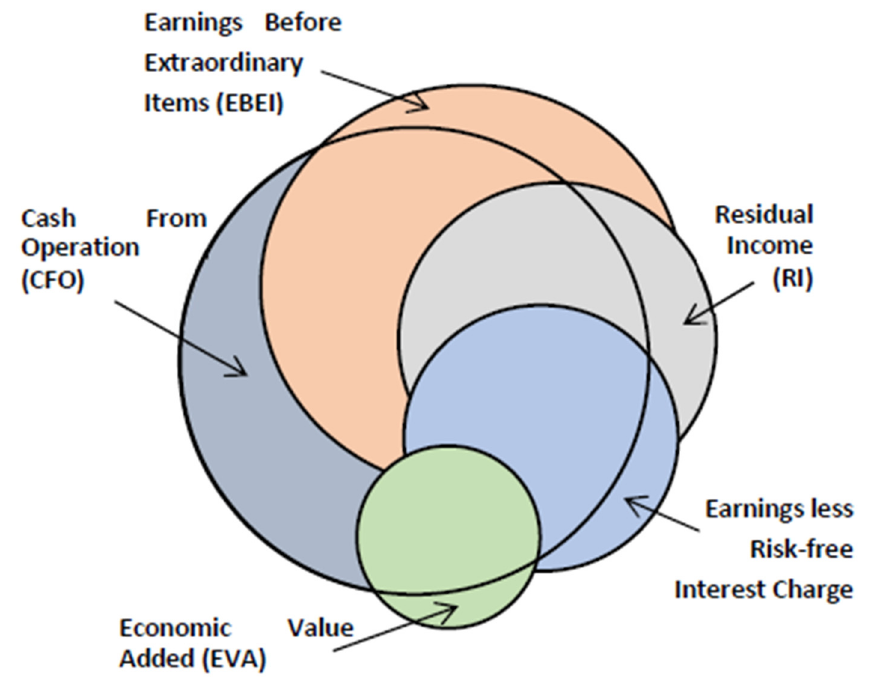
Figure 2. Illustration of relative and incremental information content of CFO, EBEI, RI, EVA, and ERIC. Relative information content is indicated by the size of the circles and is the R 2 -adjusted from Table 4; CFO = 2.6% > EBEI = 1.3% > RI = 1.0% > ERIC = 0.4% > EVA = 0.1%. Incremental information content is indicated by the non-overlapping area and is derived from F-statistics; CFO = 29.619 > EBEI = 15.326 > RI = 11.651 > ERIC = 4.761 > EVA = 1.975.